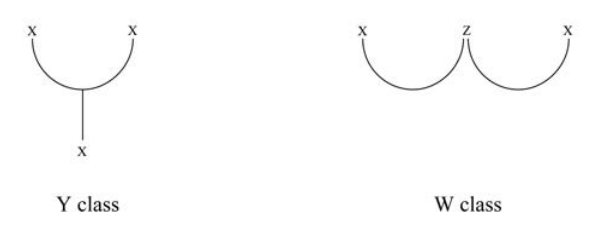
Figure 8. Iron(III) complex of